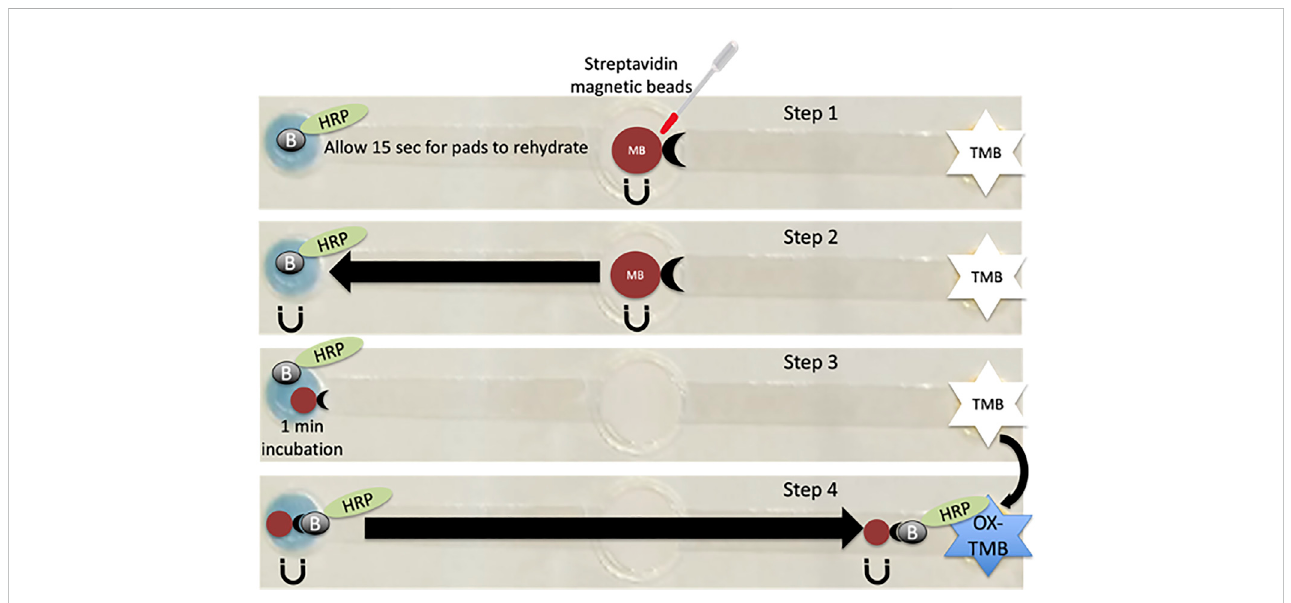
FIGURE 3 Assay operation following four steps. (1) Sample was inserted and within 15s the pads are rehydrated. (2) Magnetic beads were then slid from the inlet to Biotin-HRP reagent pad. (3) A 1-min incubation was then allotted for biotin-streptavidin.